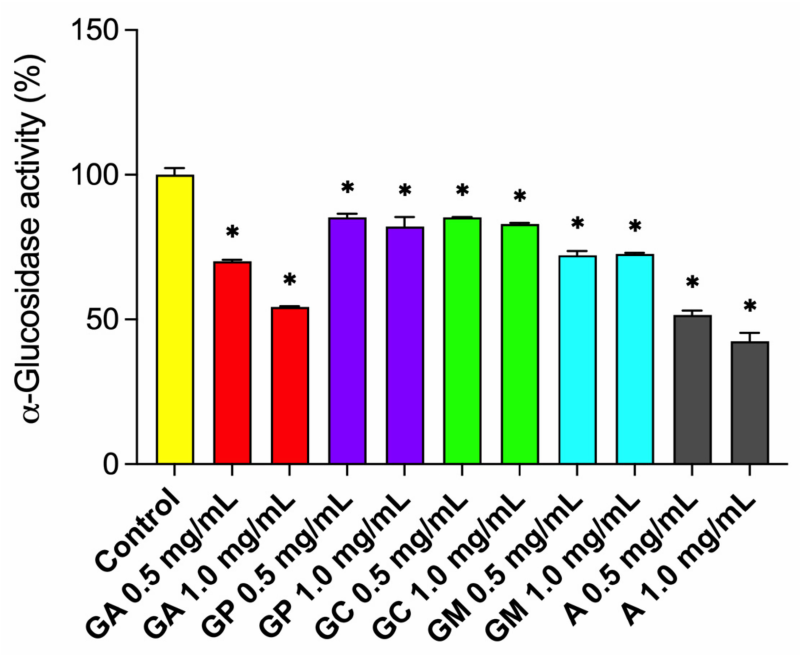
Figure 4. Effect of G. alypum ( GA ), G. punctata ( GP ), G. cordifolia ( GC ) and G. meridionalis ( GM ) methanolic leaf extracts on α -glucosidase activity (%); A—acarbose (positive control); * statistically significant difference in comparison to control ( p < 0.05); values are means + SD ( n =